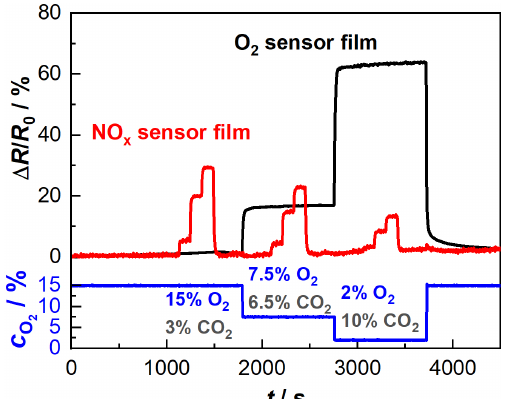
Figure 3. Response of the oxygen sensor film at different temper- atures, heated by a tube furnace (“passively heated” sensor); O 2 variation balanced in N 2 : 0.1%, 1%, 10%, 100%.